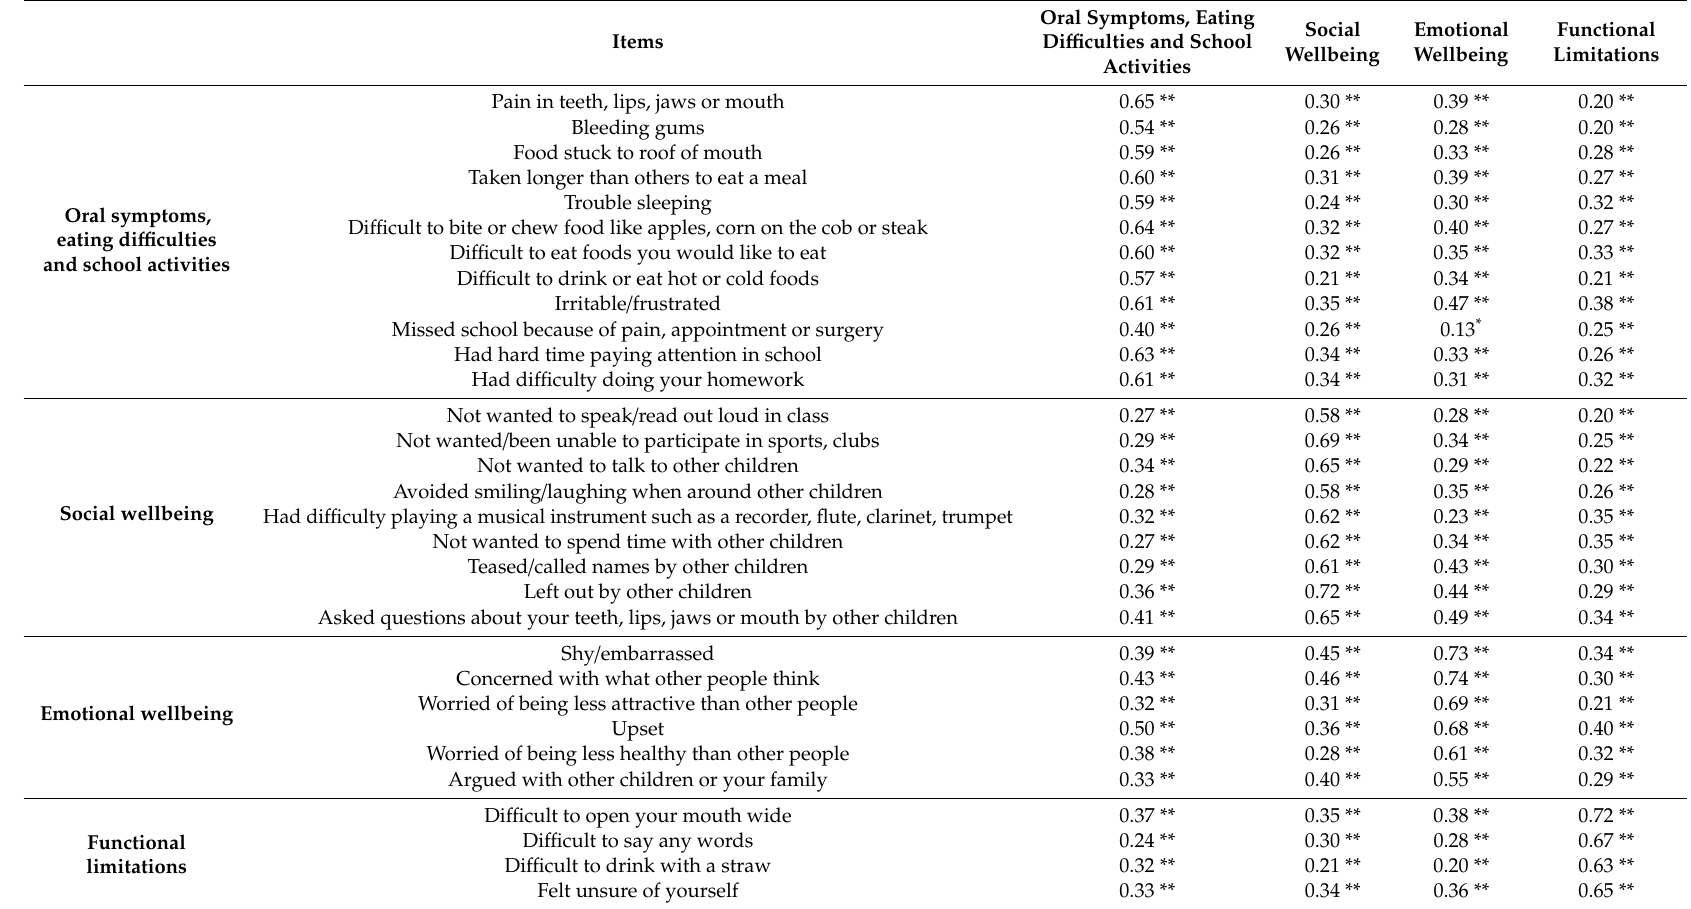
Table 3. Multi-trait scaling of the subscales of the Hindi version of CPQ 11–14. Items